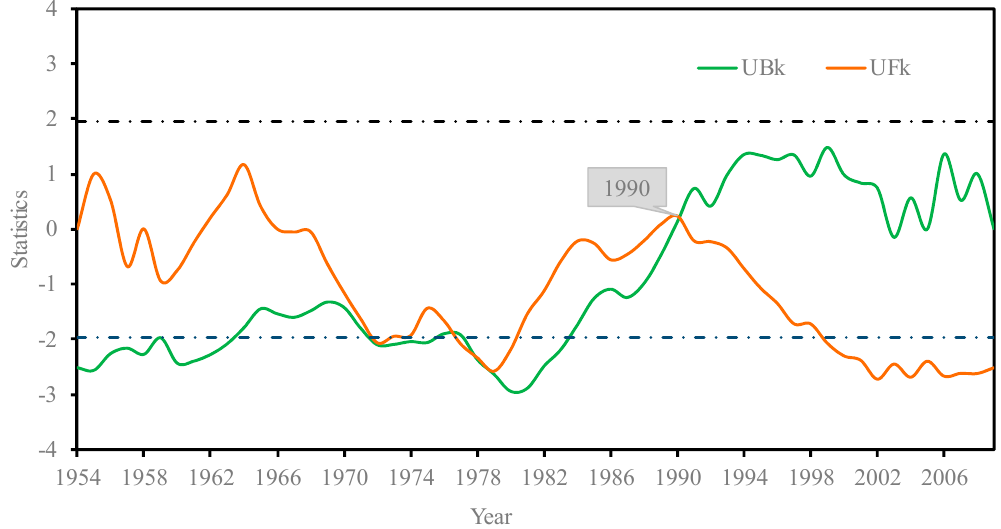
Figure 4. Mann-Kendall test results of inflow of Shiquan reservoir, UBk and UFk are time statistics.